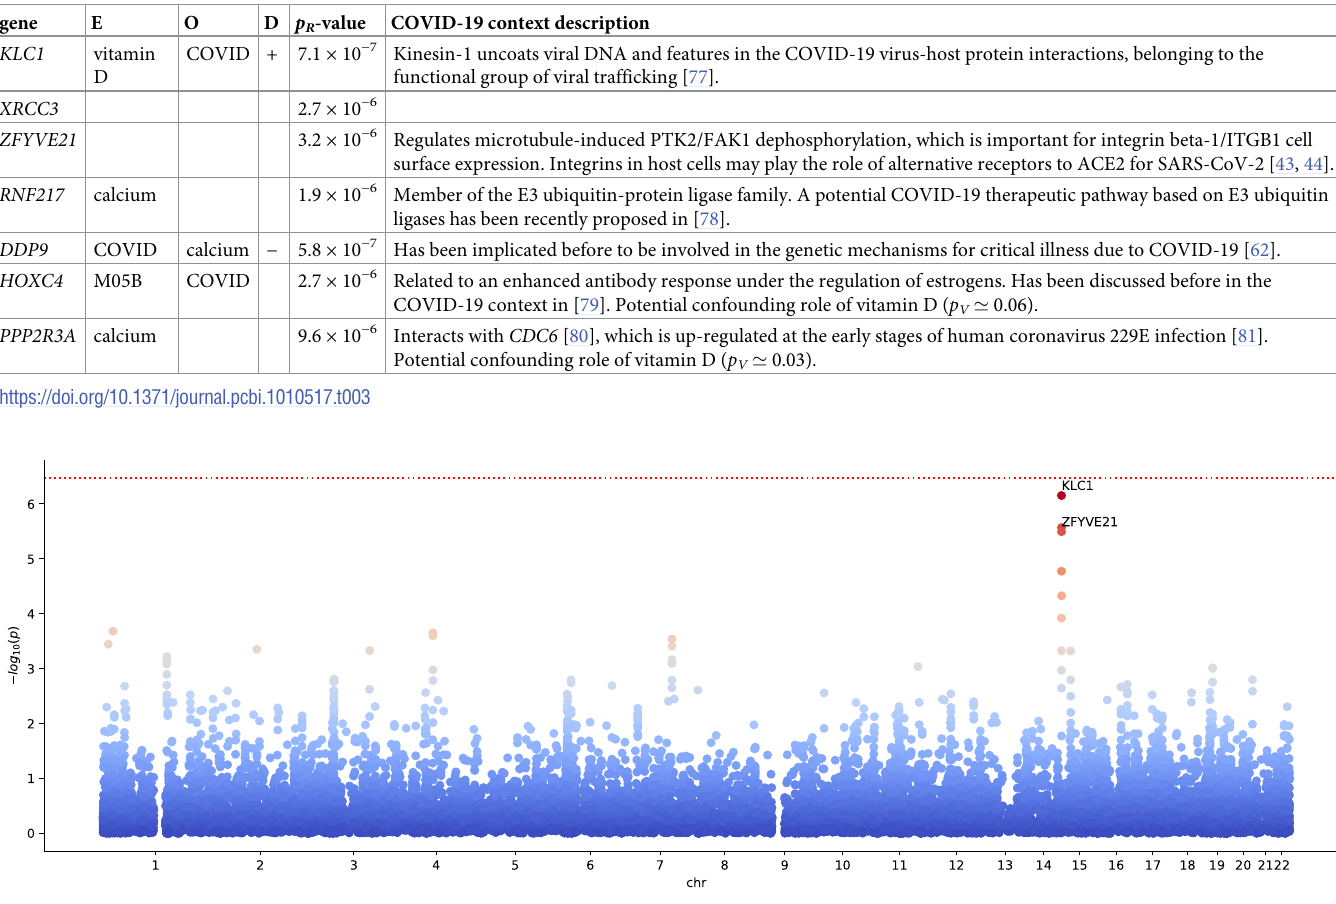
Fig 9. Manhattan plot for ratio scoring Vitamin D concentration against severe COVID-19 in the coherent case, with ratio denominator given by COVID-19. The Bonferroni significance threshold of p = 3.4 × 10 − 7 is indicated by the red dotted line (0.05 divided by the 18453 genes and 2 times 4 traits tested).